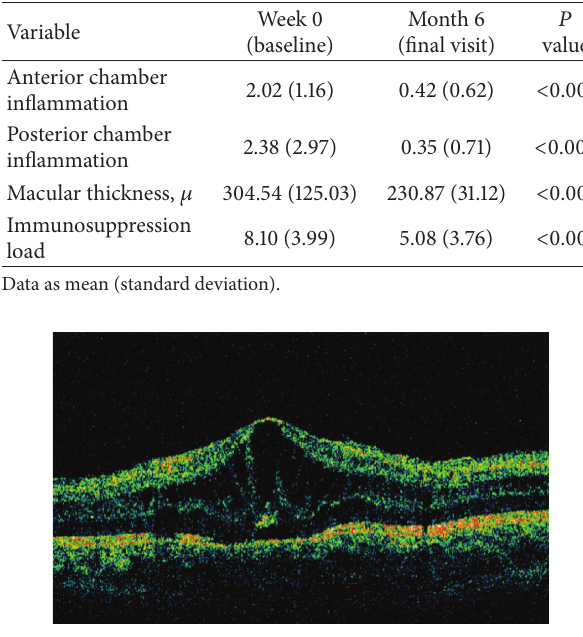
Figure 1: Ocular coherence tomography in a patient with JIA and cystoidmacularedema,withamacularthicknessof431 𝜇